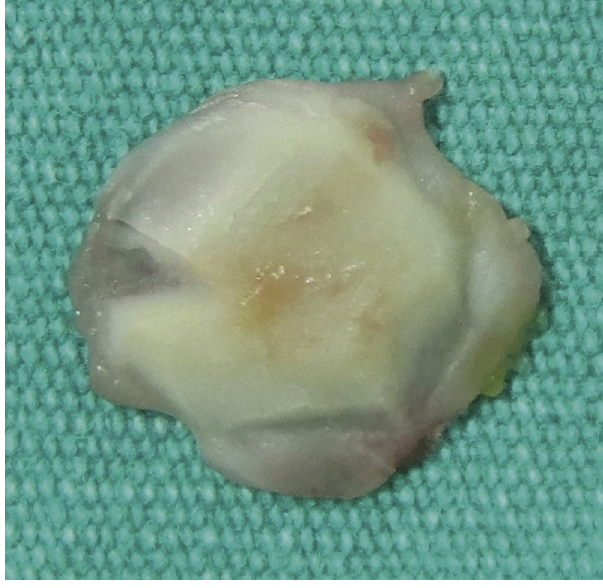
Figure 1 Conchal island graft.